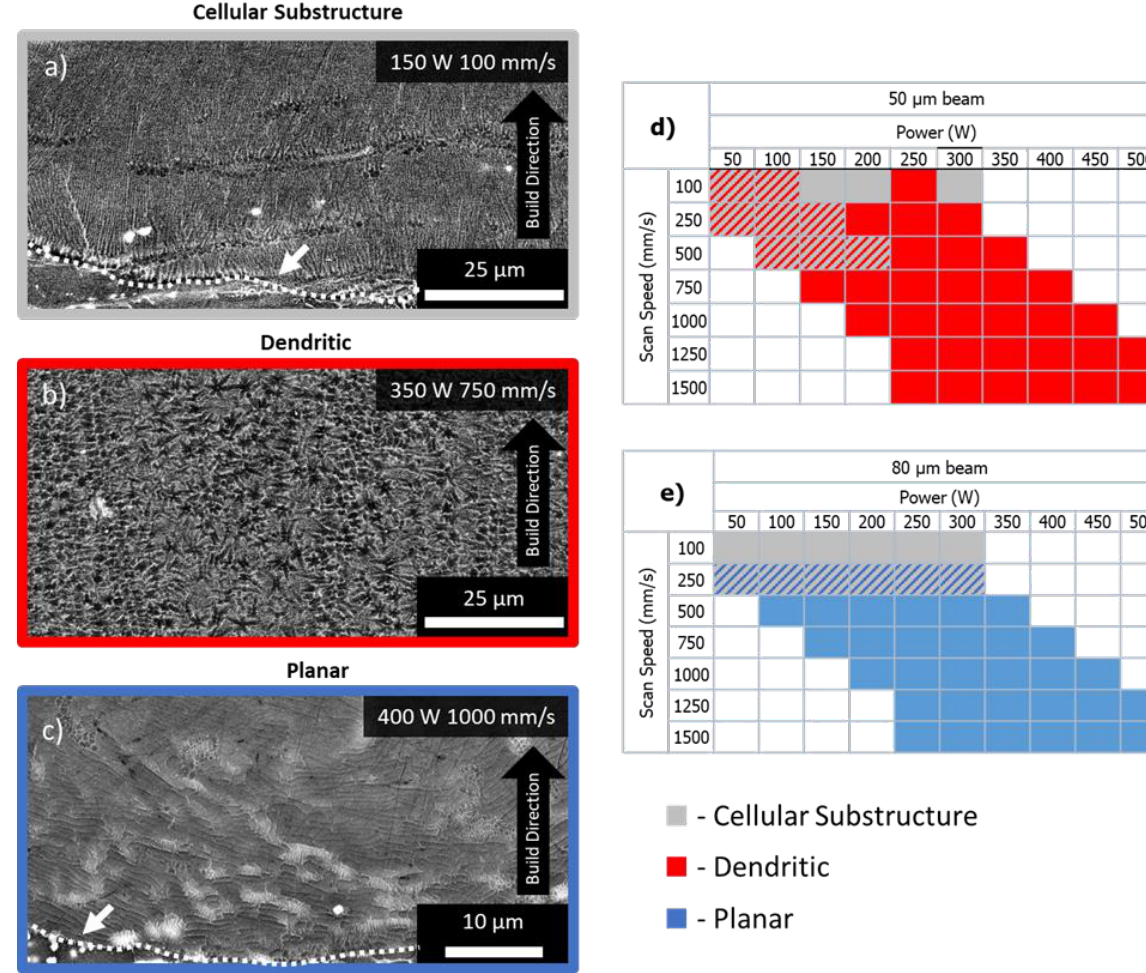
Figure 7. Examples of the three microstructural regimes observed within the melt pools in laser tracks in WE43. ( a ) The vertical cellular substructure observed in both 50 and 80 μm diameter beam-scan sets at the slowest speeds and high powers; the melt pool is outlined in white and indicated by a white arrow. ( b ) The equiaxed dendritic structure observed at high speeds in the 50 μm beam diameter set. ( c ) The planar banded structure observed at high speeds in the 80 μm diameter beam set. ( d – e ) Parameter matrix showing microstructure regimes of ( d ) tracks scanned with a 50 μm diameter beam and ( e ) tracks scanned with an 80 μm diameter beam.